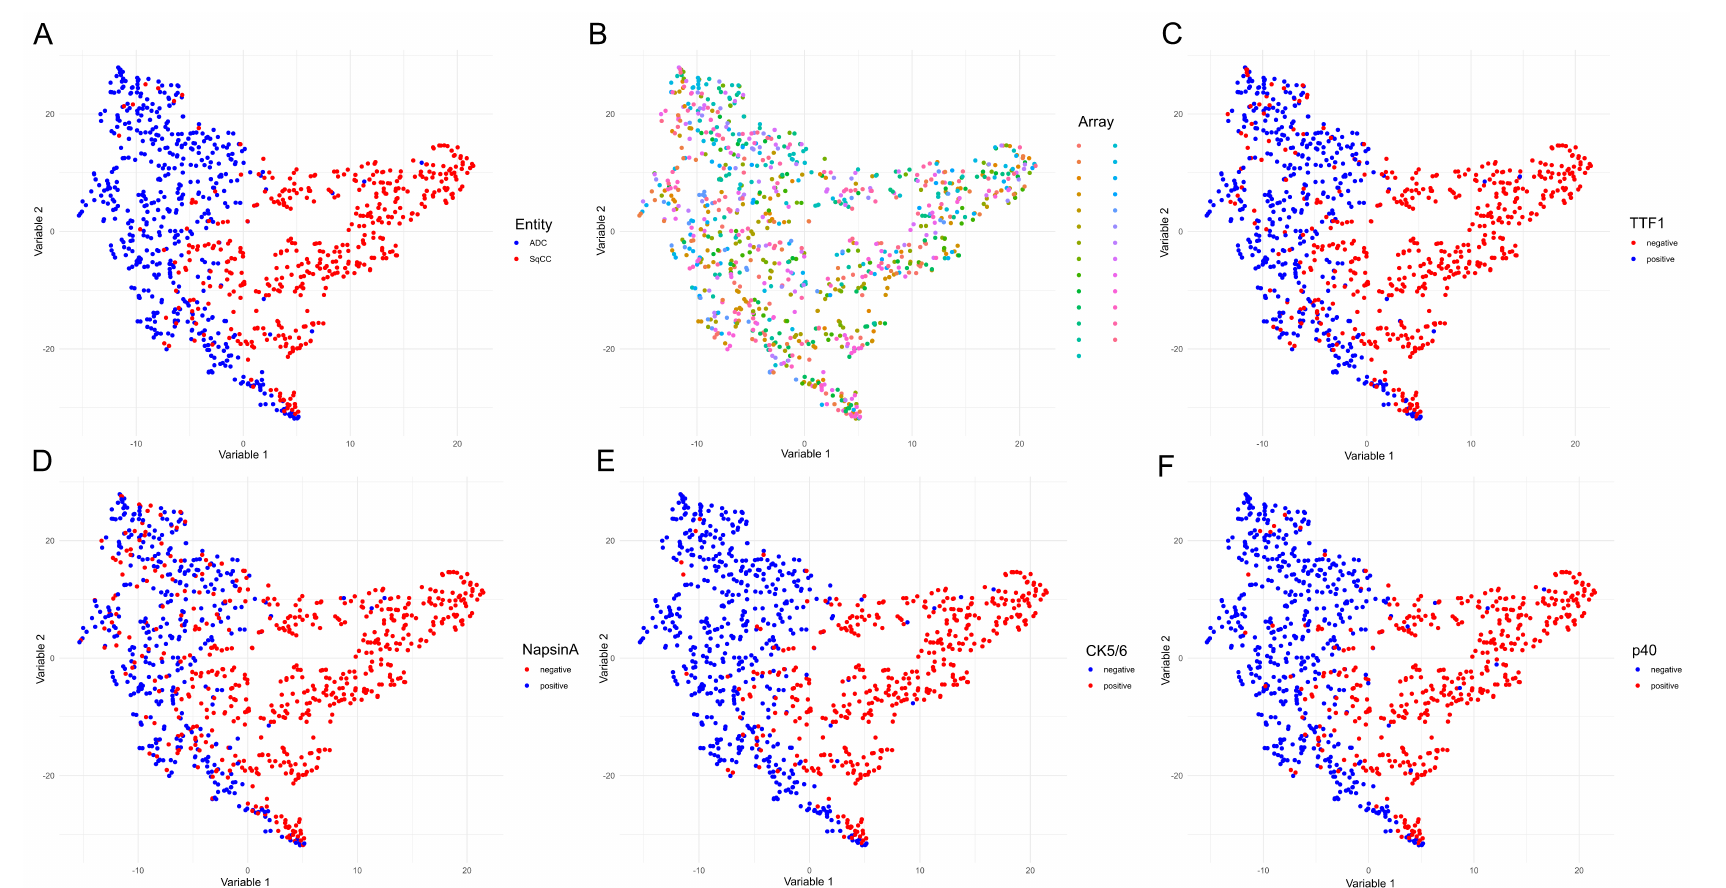
Figure 3. T-distributed stochastic neighbor embedding analysis reveals the plausibility of adenocarcinoma and squamous cell carcinoma classification based on the selected m / z values. T-distributed stochastic neighbor embedding analysis was performed including the eight previously selected m / z peaks ( m / z 1410.7, 810.4, 1406.7, 865.4, 878.5, 1234.7, 1220.7, and 1104.6). Each dot represents a single case. The data are presented with regard to tumor entity ( A ); analyzed TMA (each color represents a TMA (tissue microarray), with 24 TMAs total ( B ); TTF1 (thyroid transcription factor 1) ( C ); Napsin-A ( D ); CK5 / 6 (cytokeratin 5 / 6) ( E ); and p40 ( F